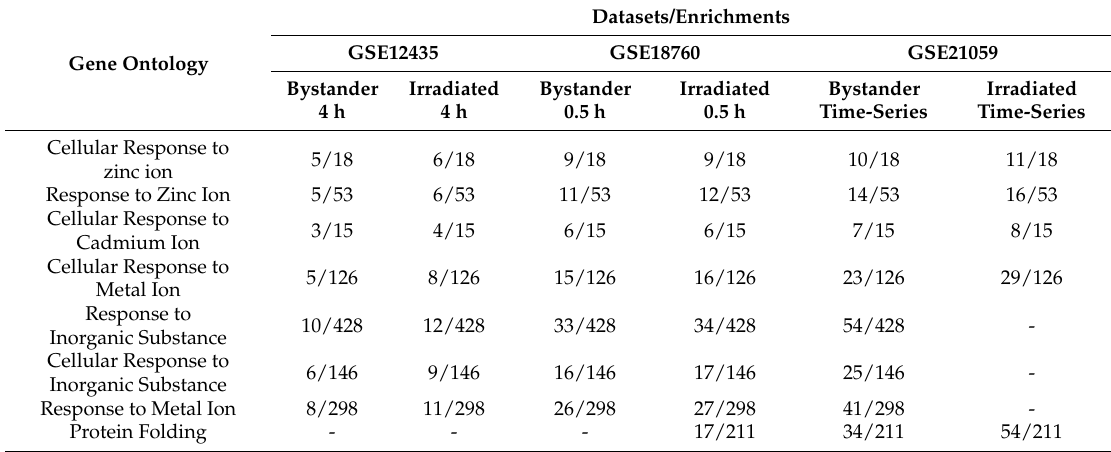
Table 3. Common Gene Ontology (GO) terms resulting from functional enrichment analysis for bystander vs. control and irradiated vs. control comparisons of datasets with α -particles irradiation. Enrichment scores are given as a fraction